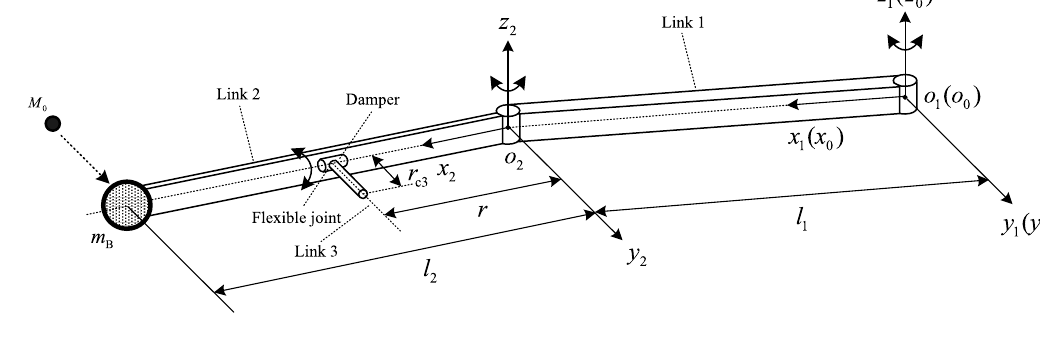
Fig. 6. Schematic of the flexible manipulator with vibration